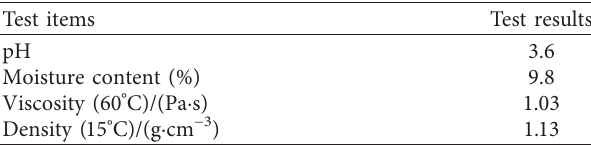
Table 3: Performance indexes of nano-CaCO